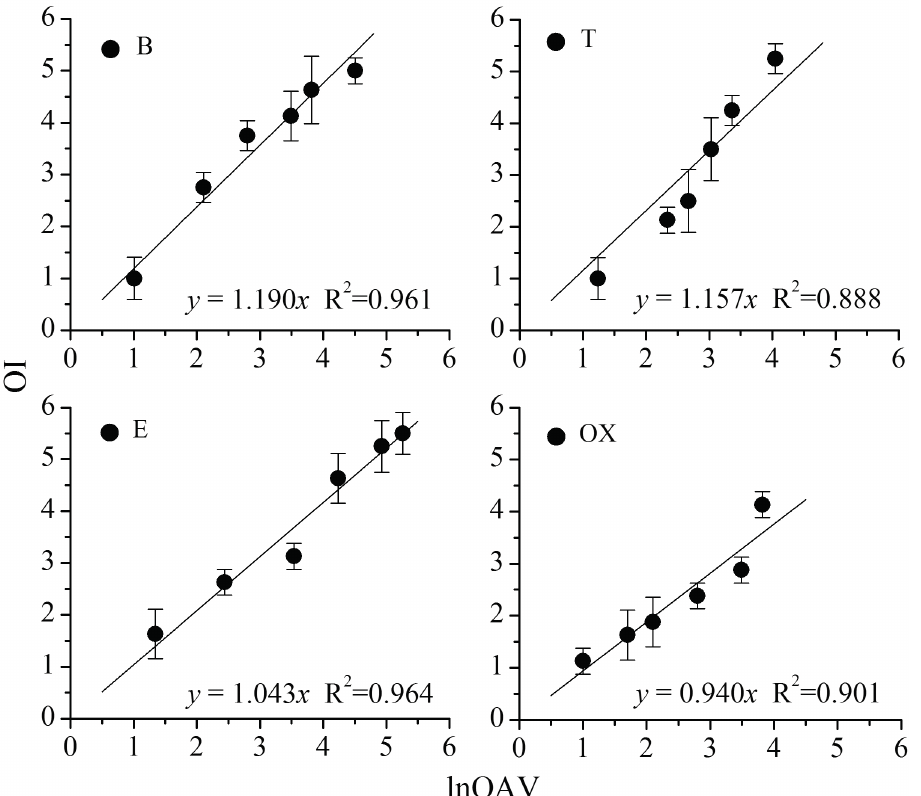
Figure 1. Linear relation between OI and lnOAV of individual benzene (B), toluene (T), ethylbenzene (E) and o -xylene